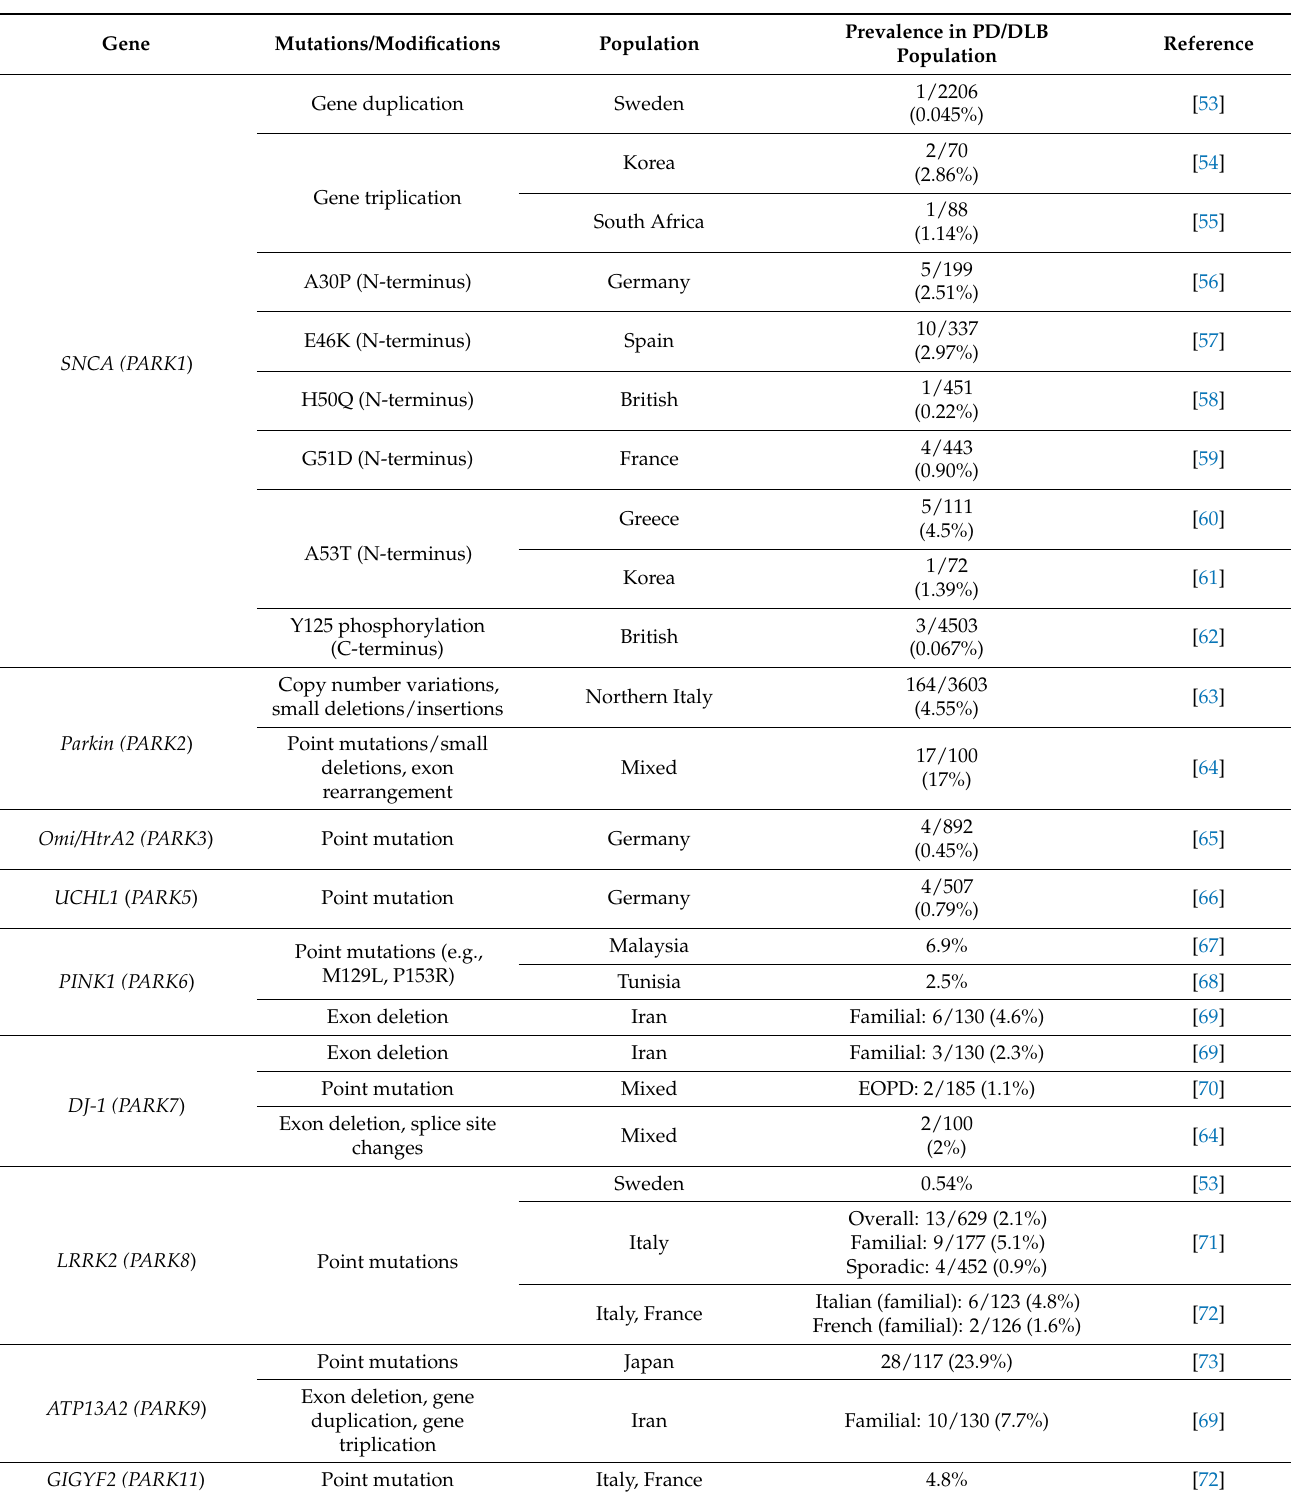
Table 1. Prominent PD/DLB mutations and modifications and their associated prevalence. In general, PD/DLB associated mutations and modifications are rare within the SCNA gene, with most alterations being found in the N-terminus of the α -syn protein. On the contrary, mutations in other genes associated with the mitochondria, the ubiquitin–proteasome pathway, and cytoskeleton are more